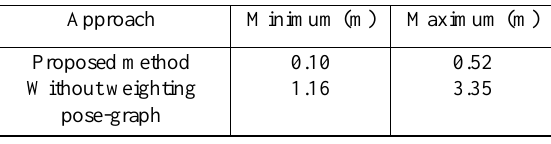
Table 2. Minimum and maximum values for the distance error.